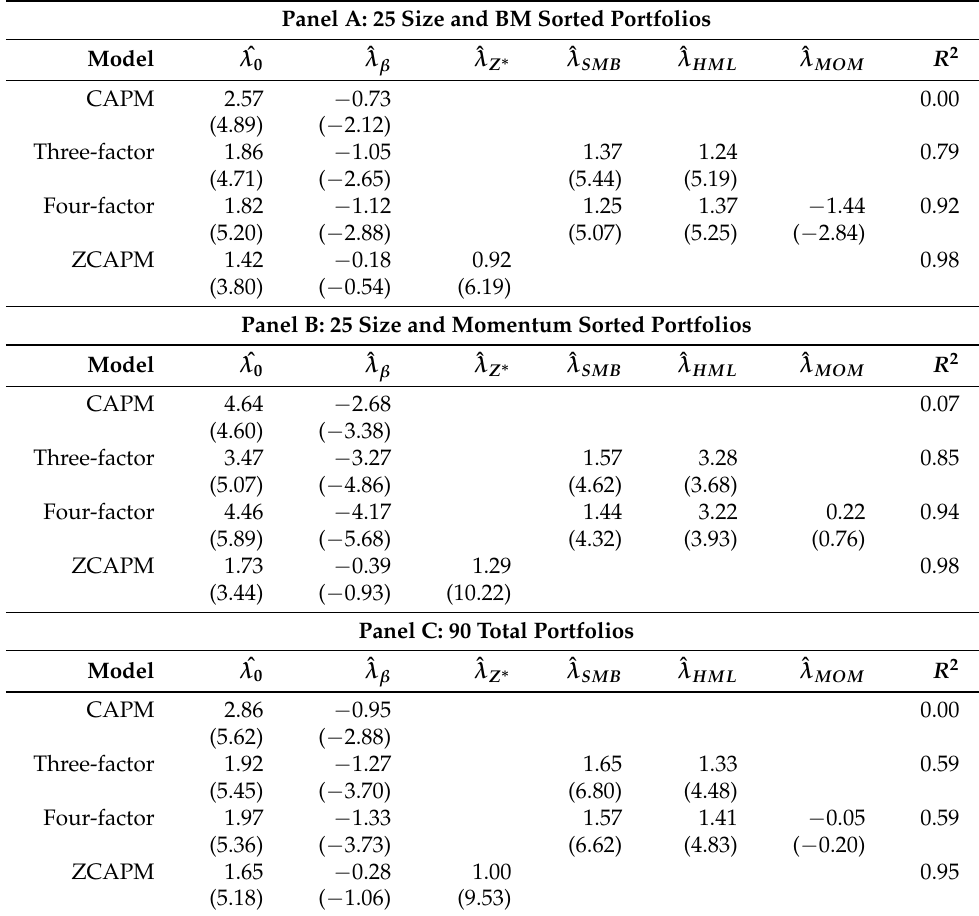
Table 2. Out-of-sample Fama–MacBeth cross-sectional regressions for U.S. stocks: January 1928 to December 1964. Panel A: 25 Size and BM Sorted